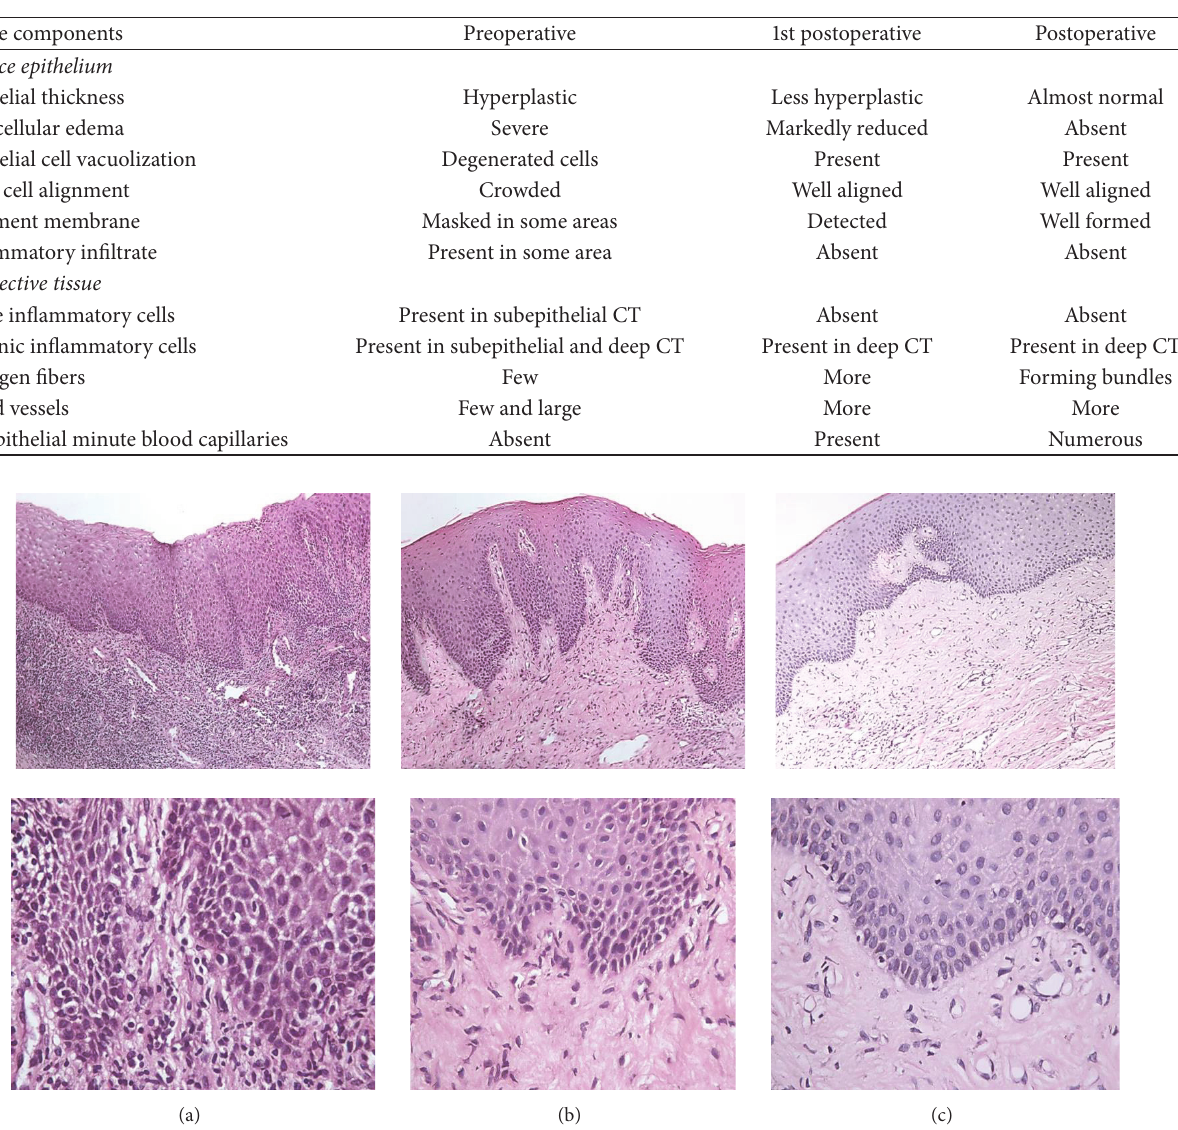
Table 1: Microscopic features of preoperative and postoperative specimens are summarized.